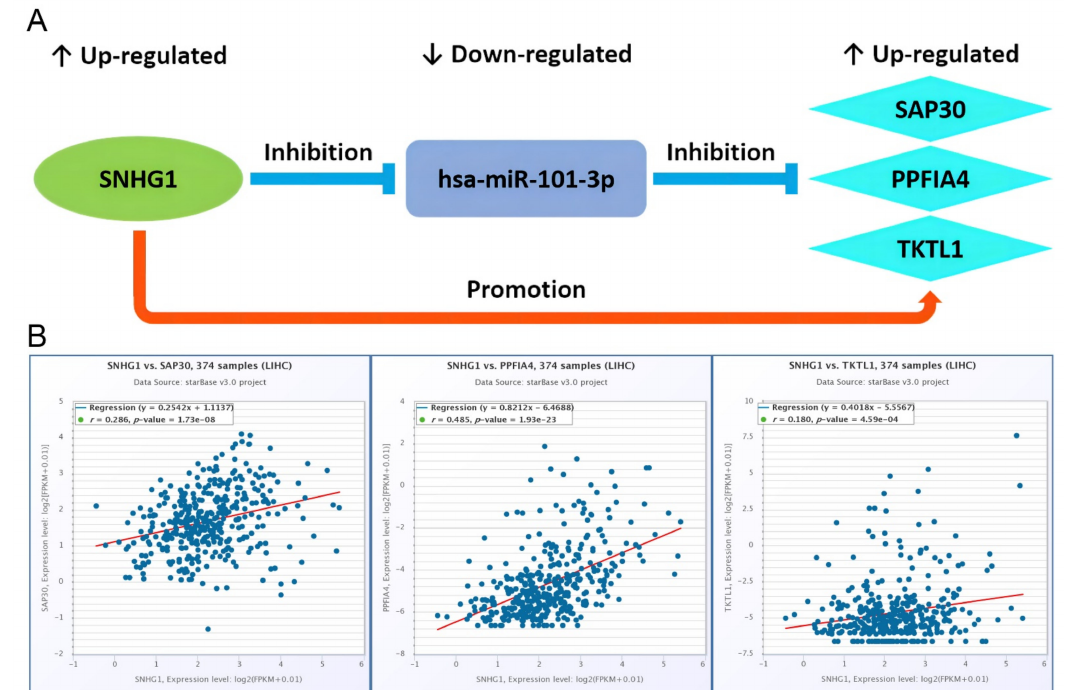
Figure 6. Recognition of three potential lncRNA-miRNA-mRNA ceRNA regulatory axes. ( A ). The targeted regulation relationship among the lncRNA, miRNA, mRNA of the three potential ceRNA regulatory axes in the HCC development. ( B ). The correlation ( p < 0.05 was considered as to be significantly correlated) of SNHG1 with PPFIA4, SAP30, and TKTL1, respectively.